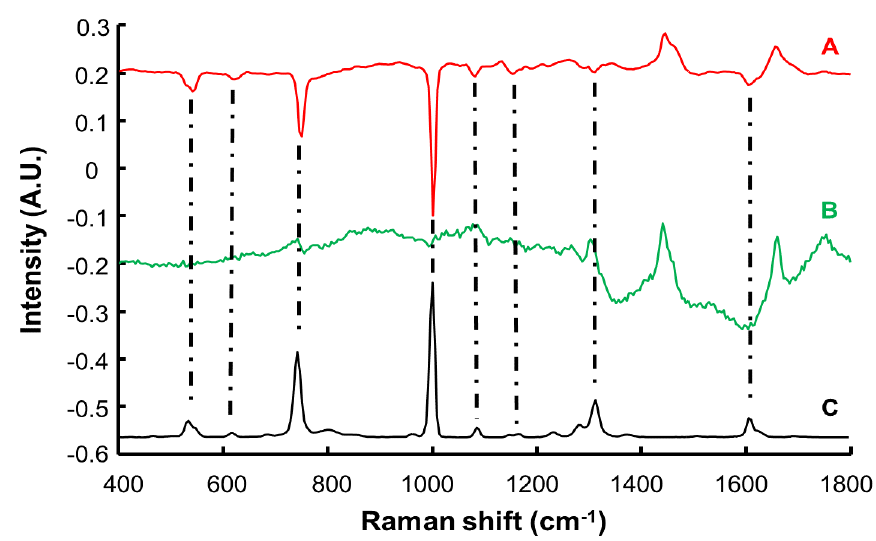
Figure 6. Loadings plot for the two first components obtained from PCA and resorcinol spectrum. A: loading of PC1, B: loading of PC2 and C: reference spectrum from resorcinol (powder) .